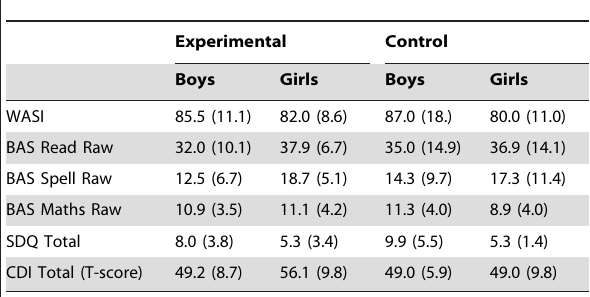
Table 1. Baseline characteristics of the groups in terms of mean (standard deviation) IQ (WASI full score), reading (BAS reading ability raw score), Spelling (BAS spelling ability raw score), maths (BAS maths ability raw score), externalising problems (SDQ total problems score), and internalising problems (CDI total T-score).